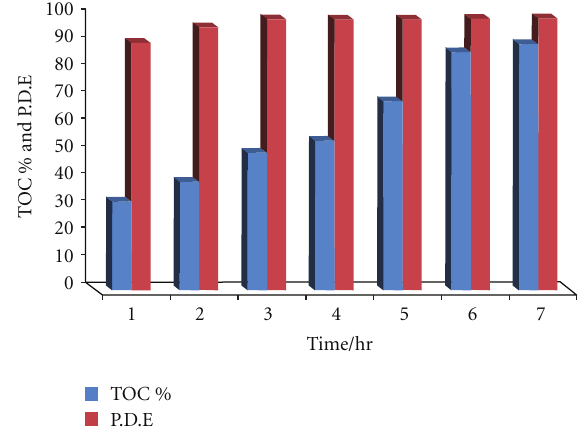
Figure 12: TOC degradation % and P.D.E for cobalamin by ZnO.